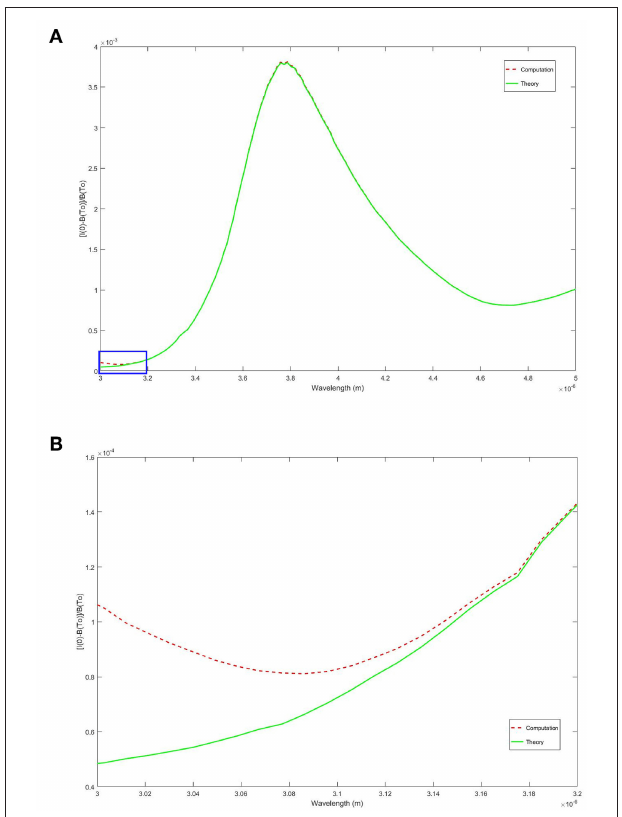
FIGURE 2 | The top figure, (A) , is a plot of the numerical and theoretical approximations over the entire MWIR band. The results compare favorably over the entire range with exception of the lower bound of the interval. (B) is a magnified view of the curves in the blue rectangle of (A) . Below 3.15 micron the numerical solution begins to slowly diverge and eventually deviates from theory at 3 micron by 119%.